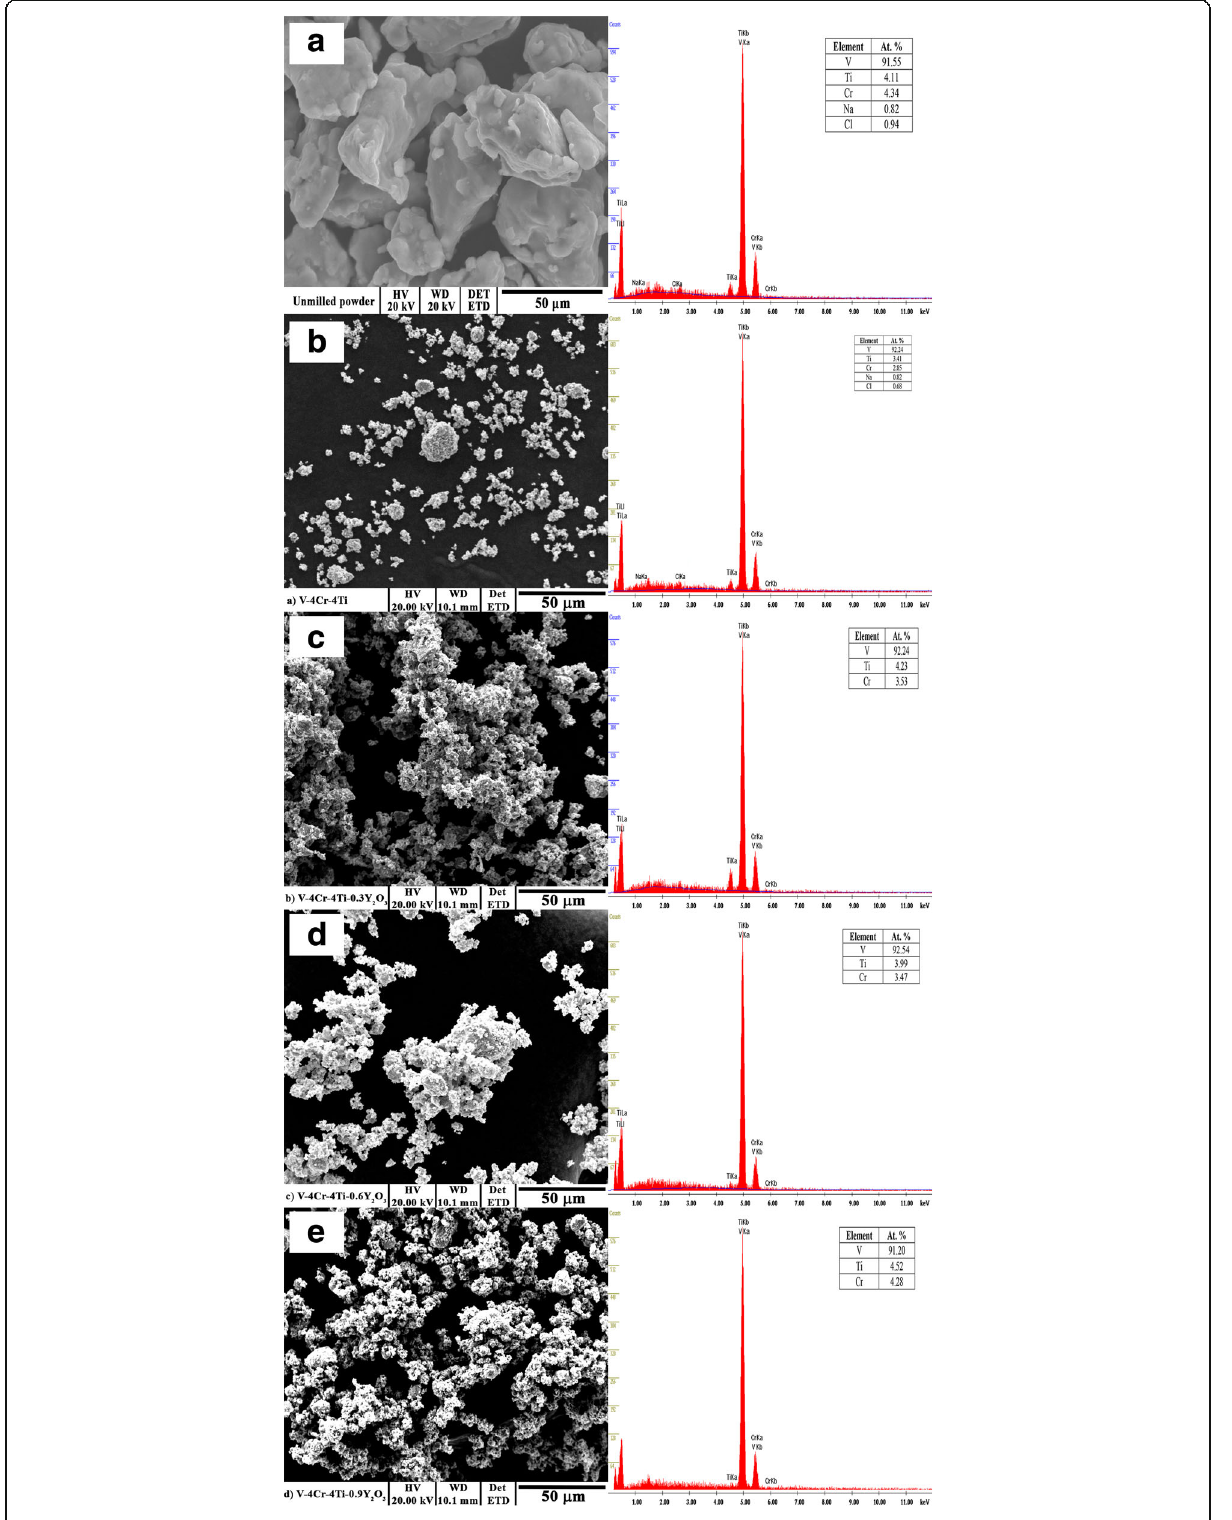
Fig. 1 Electron microscopy images accompanied with energy-dispersive absorptive spectroscopy patterns of a unmilled V – 4Cr – 4Ti powder, b milled V – 4Cr – 4Ti powder, and V – 4Cr – 4Ti powder ball-milled with varying yttria content: c 0.3% yttria, d 0.6% yttria, and e 0.9%